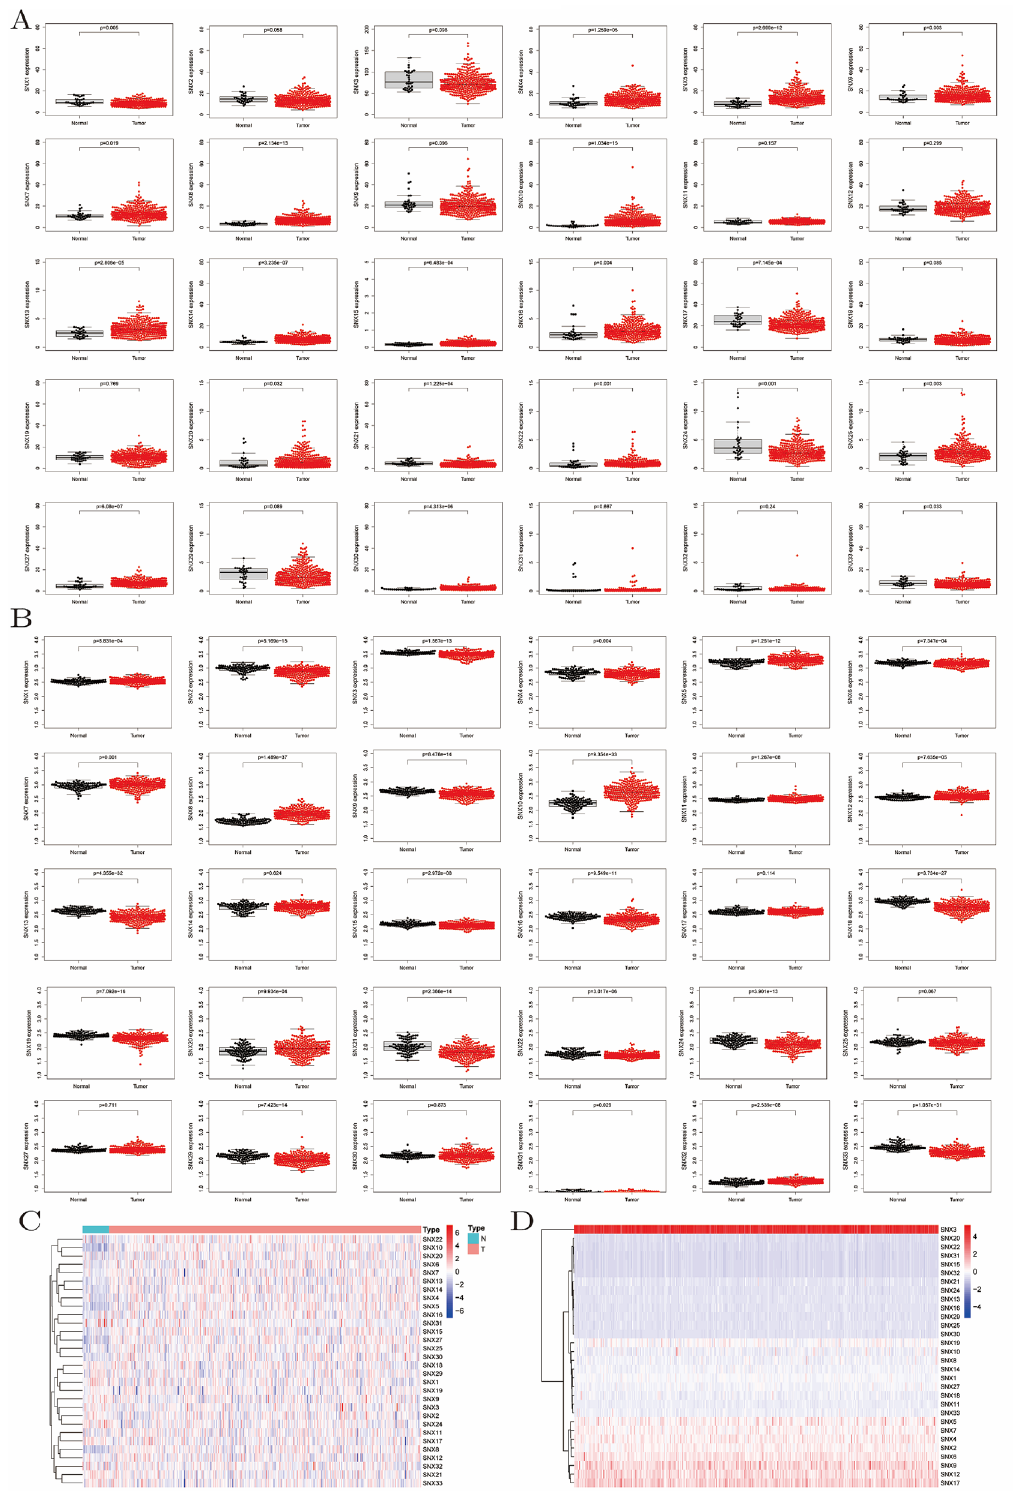
Figure 2. Transcriptional level of SNX family in GC. ( A ) SNX4/5/6/7/8/10/13/14/15/16/17/20/21/22/25/27/30 were higher expressed in tumor, while SNX1/24/33 did the opposite, with no record of SNX23/26/28 in TCGA transcriptome. SNX2/3/9/11/12/18/19/29/31/32 showed no statistic significant in analysis of expression profile. ( B ) Differential expression analysis of 30 SNXs based on GSE66229 as verification, with data of